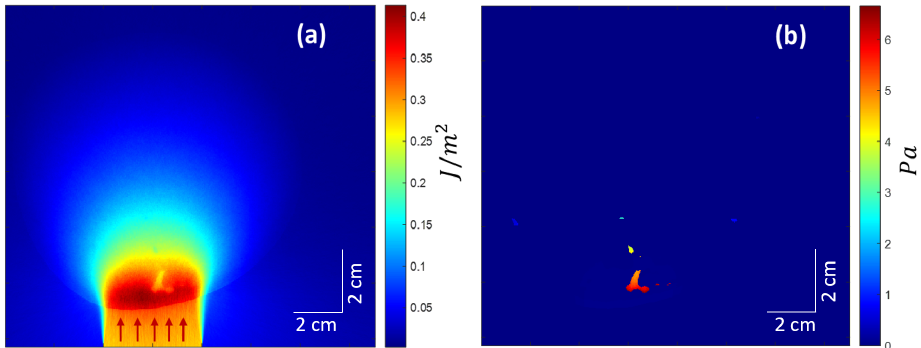
Figure 3. ( a ) Optical fluence distribution in the medium. Red arrows suggest the incident light beam direction. ( b ) The initial pressure rise distribution.